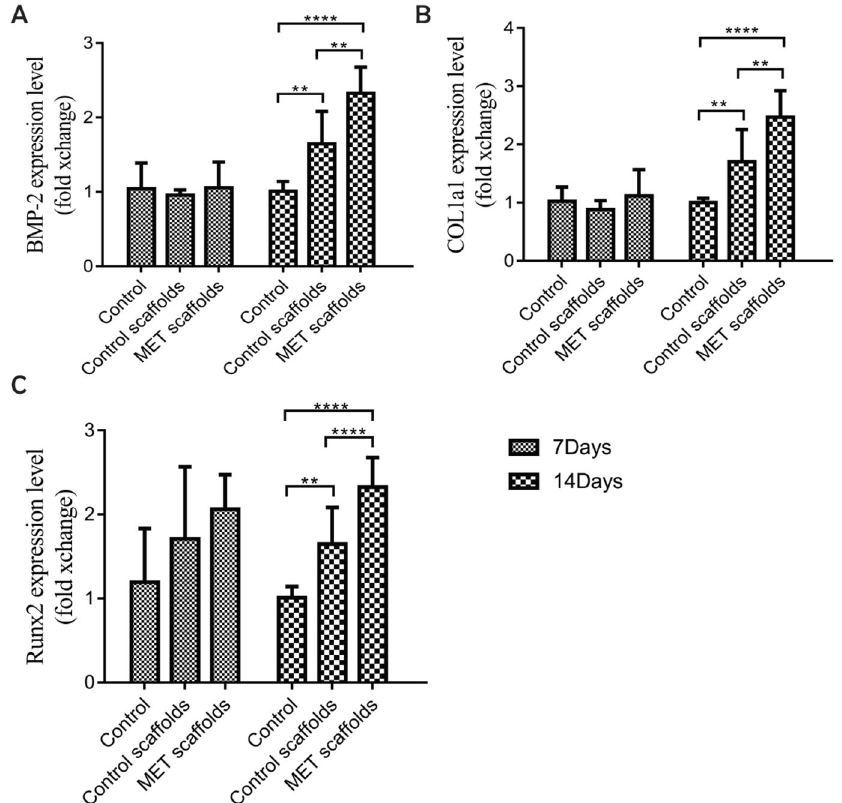
Fig. 5 A Effects of the scaffolds on mRNA expression of the BMP-2 gene on days 7 and 14. B Effects of the scaffolds on mRNA expression of the COL1a1 gene on days 7 and 14. C Effects of the scaffolds